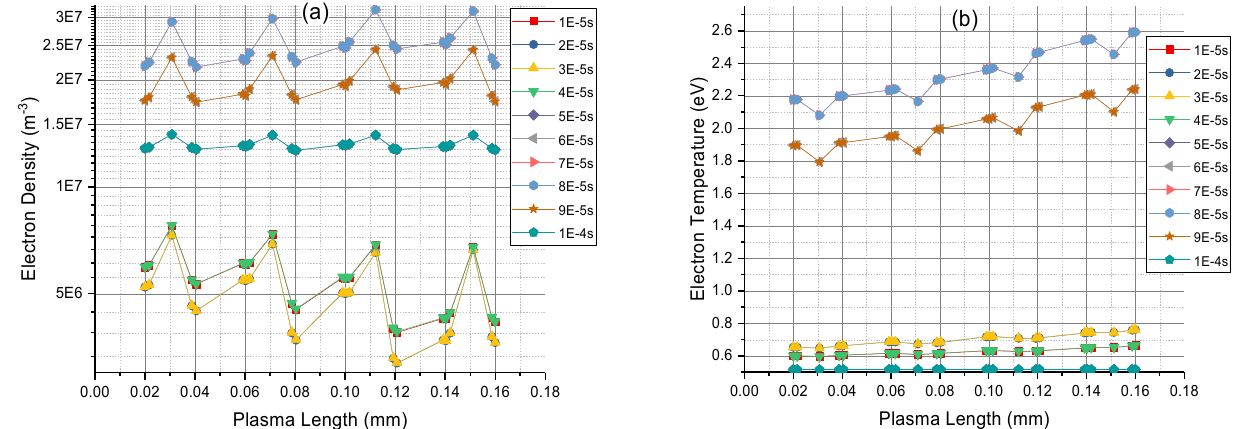
Figure 13. Plasma properties 0.01 mm above four pores of porous anodic alumina in the CPED: ( a ) electron density, ( b ) electron temperature.